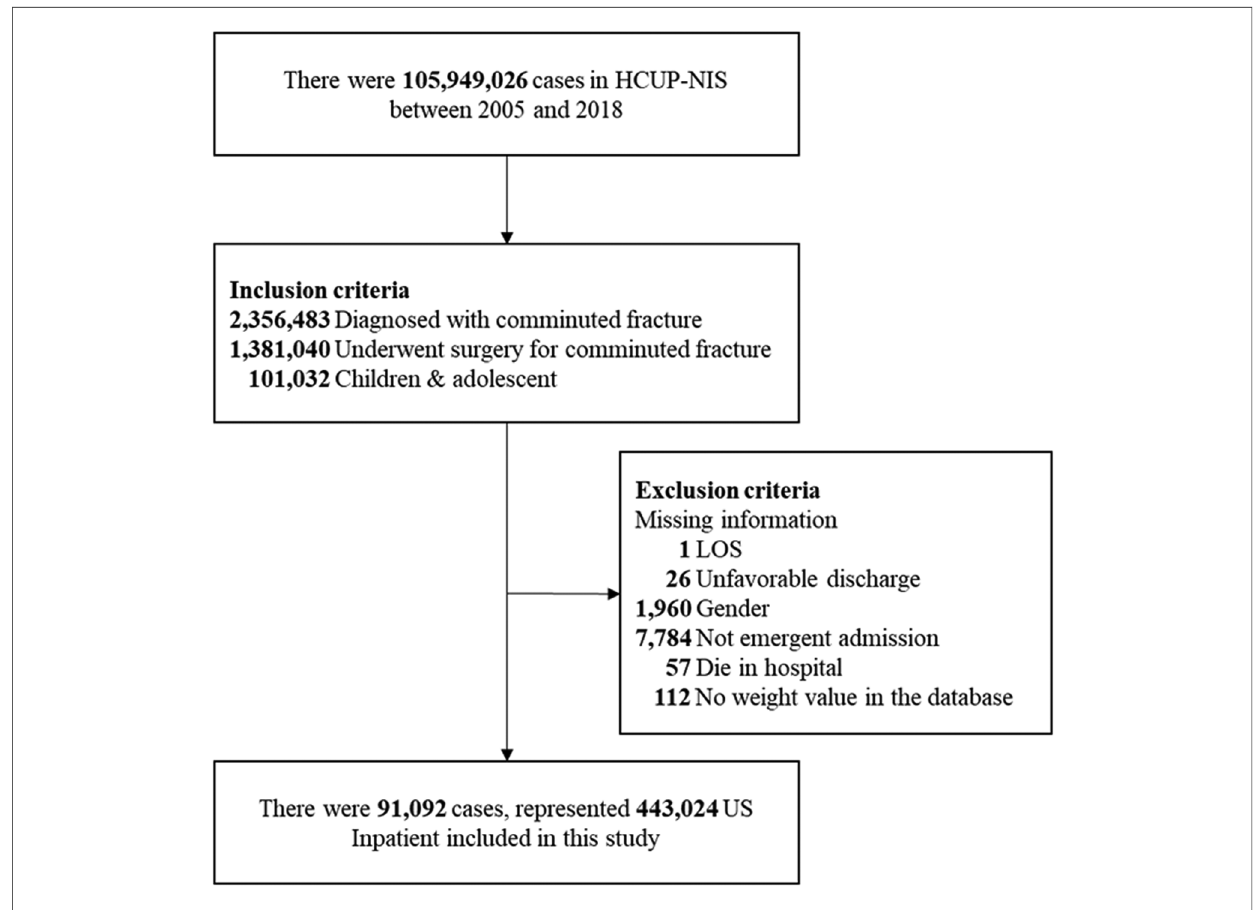
FIGURE 1 Flow diagram of study sample